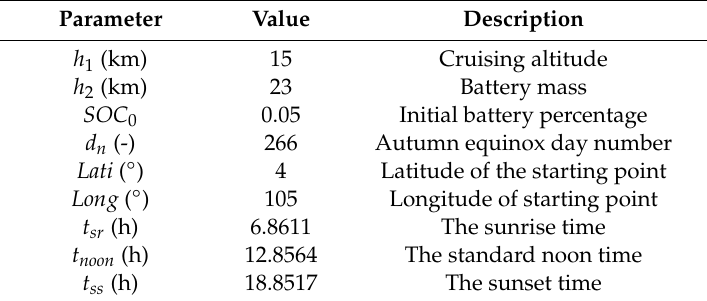
Table 3. The parameters of simulation conditions.